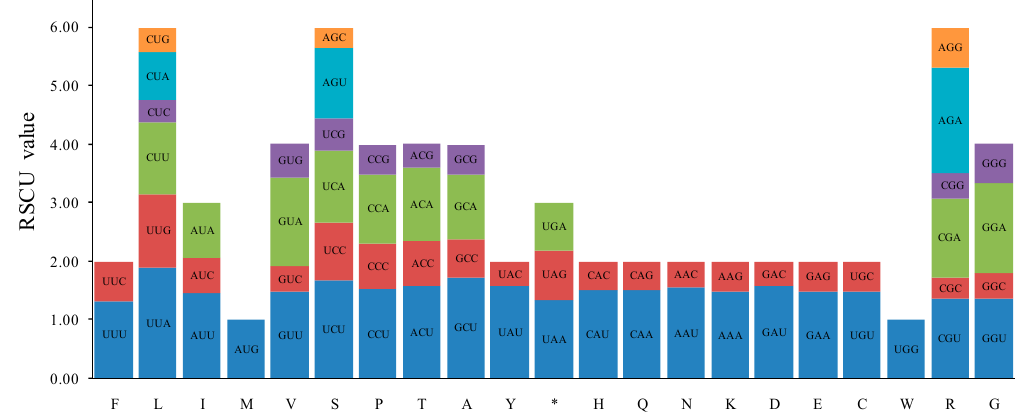
Figure 2. Codon content for the 20 amino acids and stop codons in 85 protein-coding genes in the five Aconitum species chloroplast genomes. RSCU: relative synonymous codon usage; F: phenylalanine;